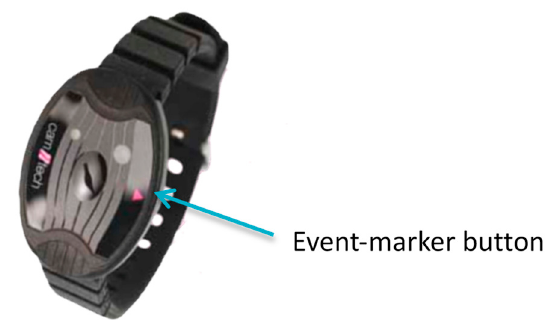
Figure 2. The actigraphy device.